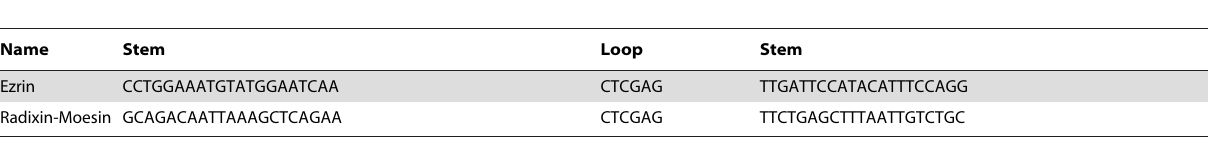
Table 2. The information of shRNAs to ezrin,radixin,moesin